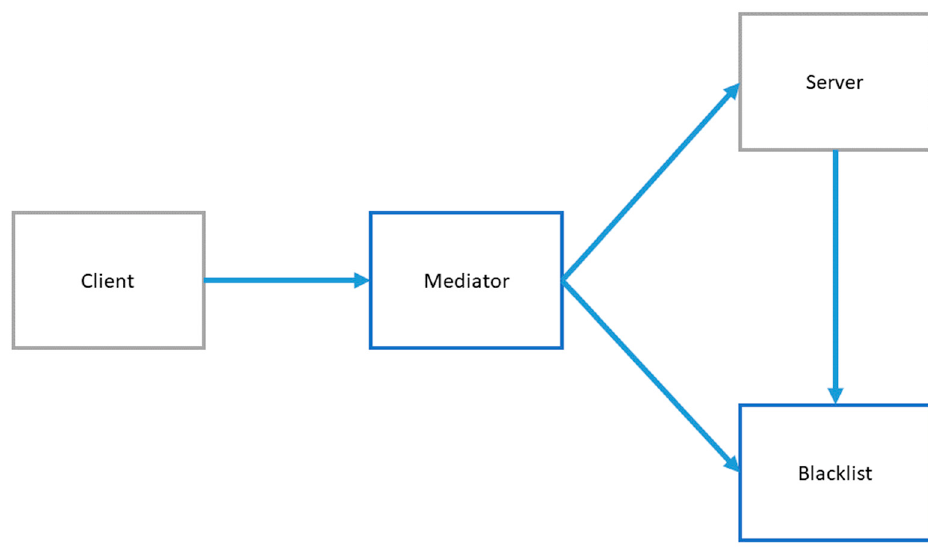
Figure 18. Conceptual overview of Blacklist pattern [15].